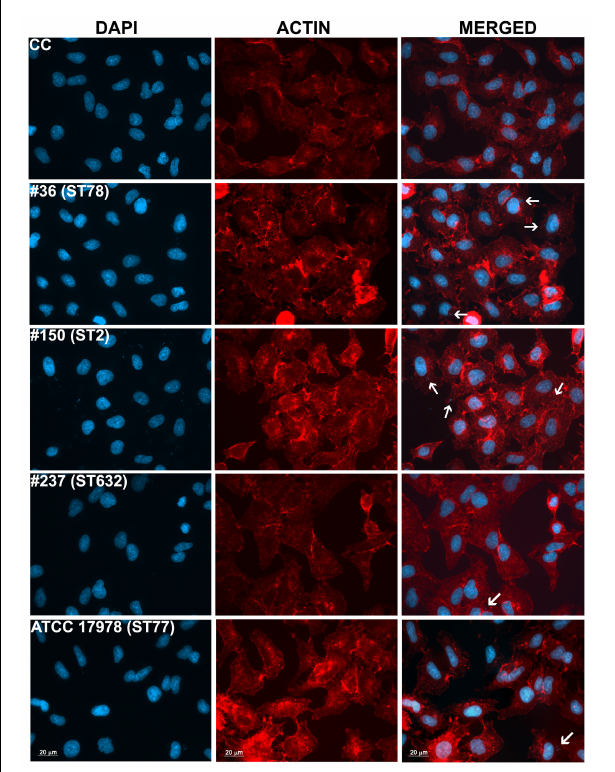
FIGURE 6 | Intracellular localization of A. baumannii in epithelial cells. Semi-confluent A549 cell monolayers were infected as reported before. At 12-h post-infection, cells were fixed and actin was stained with rhodamine-conjugated phalloidin (red), while nuclei and bacterial DNA were stained with DAPI (blue). Images, representatives of at least three independent experiments, in duplicate, were captured using a Leica camera and processed using Qwin software (Leica). Arrows point representative intracellular bacteria. Uninfected cells were used as control (CC). Scale bar, 20 µ